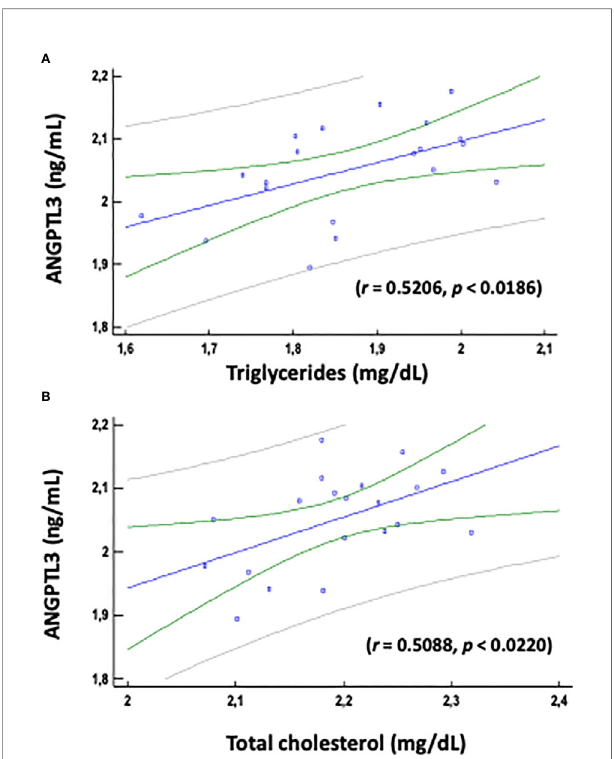
FIGURE 2 | Pearson's correlation coef fi cient between serum ANGPTL3 levels and triglycerides (A) and total cholesterol (B) variables was determined for healthy non – pregnant women. P<0.05 (two-tailed signi fi cance). Log- transformed (log10) values were used. Linear regression presenting the associations of ANGPTL3 with triglycerides and total